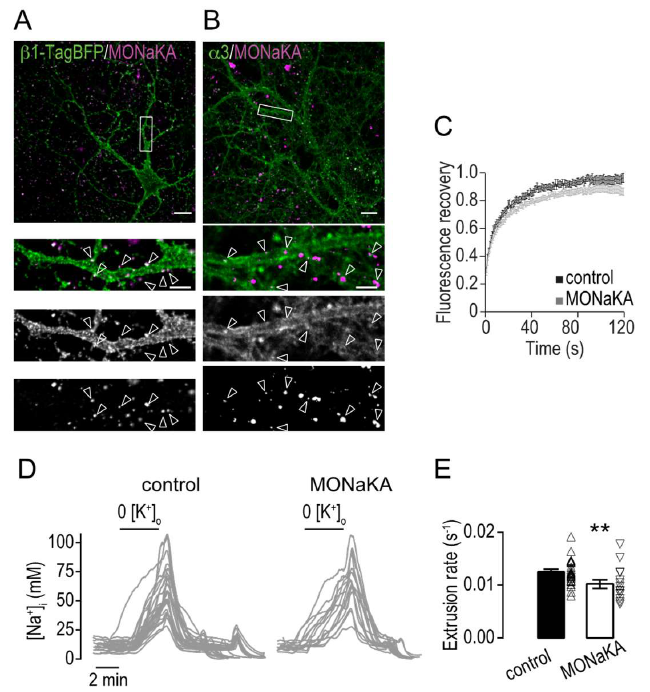
Figure 5. Clustering of Na,K-ATPase by MONaKA affects intracellular Na+ clearance. ( A ) Representative confocal images of hippocampal neurons expressing β1-TagBFP incubated with myc - tagged MONaKA (0.1 μM for 24 h). Scale bar represent 20 μm. Insets, higher magnification of the single fluorescence channels from the regions in the white rectangles. Scale bars represent 5 μm. White arrows indicate overlap of α3 and MONaKA clusters. ( B ) Representative confocal images of hippocampal neurons incubated with myc -tagged MONaKA (0.1 μM for 24 h) and stained for c- myc and endogenous α3. Scale bar represent 20 μm. Insets, higher magnification of the single fluorescence channels from the regions in the white rectangles. Scale bars represent 5 μm. White arrows indicate overlap of α3 and MONaKA clusters. ( C ) Mean ± SEM of the normalized fluorescence intensity after photobleaching over time in dendritic segments of neurons incubated with vehicle (control, black, n = 17 cells, 3 cultures) or MONaKA (0.1 μM, 24 h, grey, n = 25 cells, 3 cultures). ( D ) Example traces of [Na + ] i recordings in single dendrites of hippocampal neurons challenged with transient perfusion of K + -free buffer in control conditions or when treated with MONaKA (0.1 μM, 24 h). ( E ) Bar plots of the mean ± SEM Na + extrusion rate in control conditions (black, n = 29 dendrites, 14 cells, 3 cultures) or when treated with MONaKA (0.1 μM, 24 h, white n = 14 dendrites, 6 cells, 3 cultures). Individual data values are shown in open symbols for each group. The Na + extrusion rate was defined as the maximum initial Na + extrusion rate normalized by the maximum [Na + ] i value during the K + -free challenge. Significance was tested with the Mann–Whitney test. ** p < 0.01.